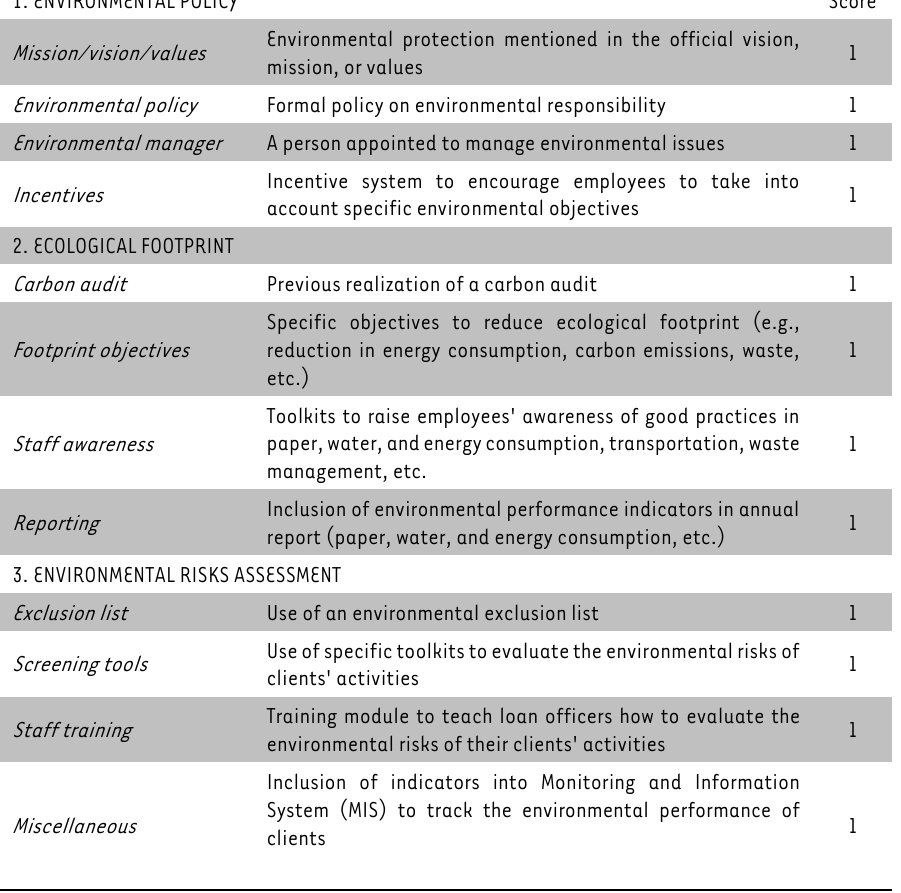
TABLE 2: Microfinance Environmental Performance Index (MEPI) scoring